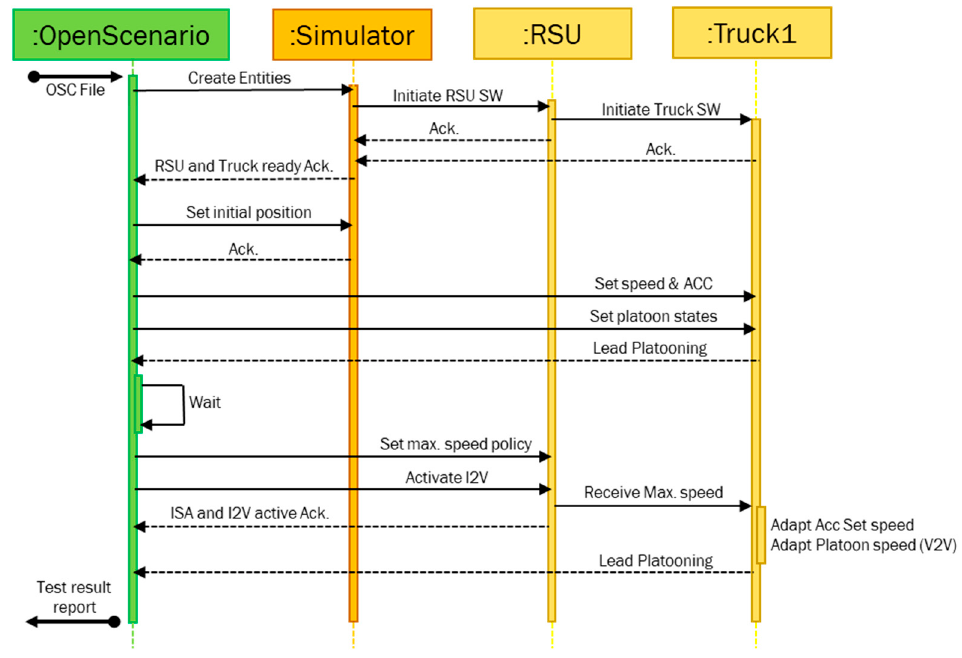
Figure 9. ISA sequence diagram. The leading truck (Truck 1 of the platoon) receiving a speed limit update (via IVI messages) from the digital infrastructure.